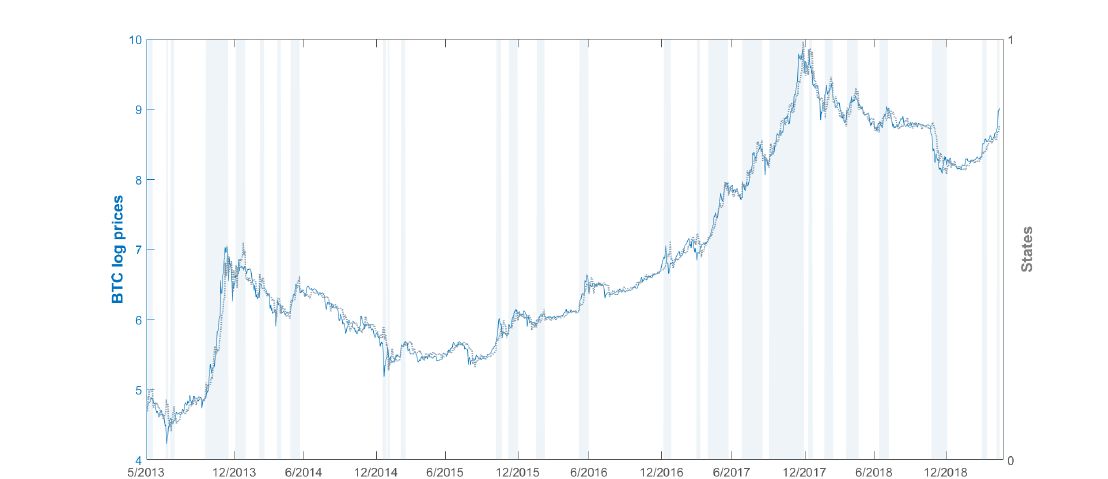
Figure 3. Logarithmic BTC prices series (blue line) and in-sample estimated logarithmic BTC price series for the period 5/2013–5/2019 (gray dotted line). Shaded bars mark times with hidden state 1 (smoothed probability above 0.5). The change of the sample sizes has a significant impact on the distribution of the unobserved process.